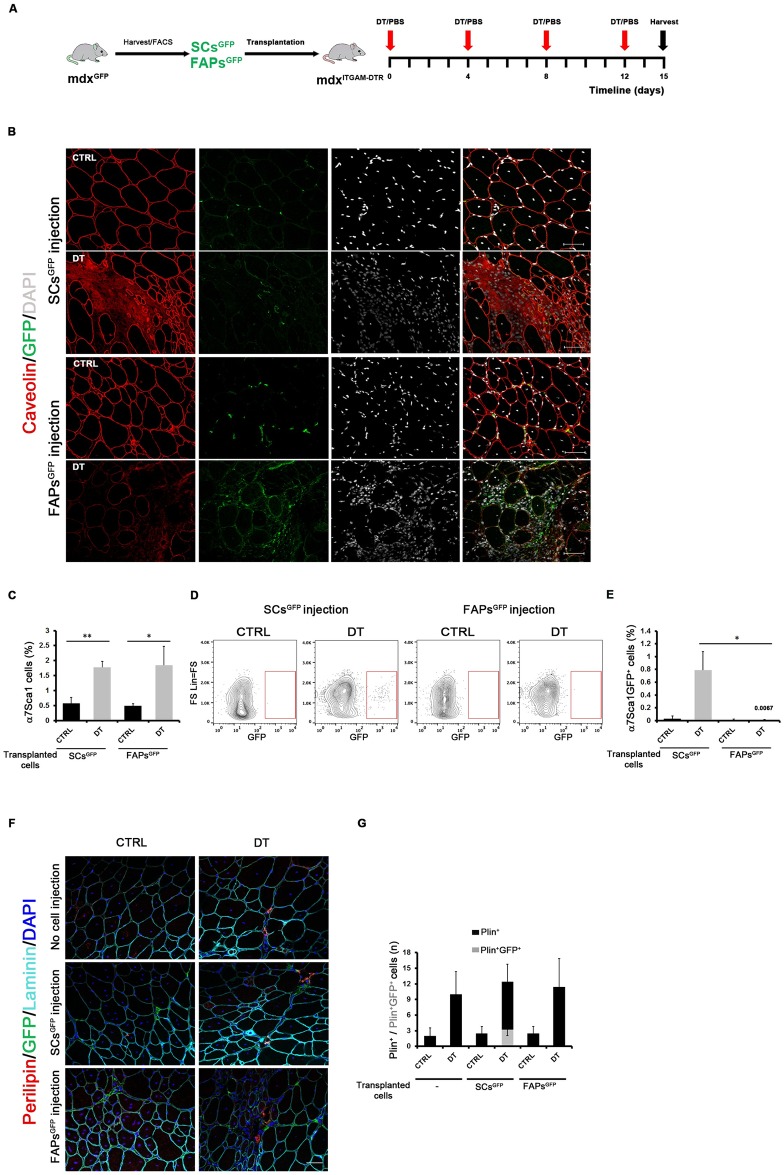
α7Sca1 cells derive from SCs upon MΦ depletion in dystrophic muscles.(A) Schematic representation of transplantation experiment. A detailed description is reported in the Results section. (B) Representative images of double staining anti-caveolin (red) and anti-GFP (green) of TA cryosections of mdxITGAM-DTR mice transplanted with SCsGFP and FAPsGFP and injected with PBS (CTRL) or DT. Nuclei were counterstained with DAPI (white); n = 3 animals for each experimental group. Scale bar = 50 μm. (C) Percentage of α7Sca1 cells purified from Lin- cell population of PBS or DT-injected mdxITGAM-DTR mice transplanted with SCsGFP and FAPsGFP; the percentage of α7Sca1 cells is reported as relative to whole mononucleated cells; n = 3 animals for each experimental group; each replicate was the pool of 2 mice; unpaired t test was used for comparison (*, P<0.05; **, P<0.01). (D) Representative FACS plot showing α7Sca1 GFP+ cells sorted from PBS (CTRL) or DT-injected mdxITGAM-DTR mice transplanted with SCsGFP or FAPsGFP. (E) Graph reporting the percentage of α7Sca1 GFP+ cells sorted from PBS or DT-injected mdxITGAM-DTR mice transplanted with SCsGFP or FAPsGFP; the percentage of α7Sca1 GFP+ cells is reported as relative to whole mononucleated cells; n = 3 animals for each experimental group; each replicate was the pool of 2 mice; unpaired t test was used for comparison (*, P<0.05). (F, G) Representative images of triple staining anti-perilipin (Plin) (red), anti-GFP (green), anti-caveolin (cyan) of TA cryosections of mdxITGAM-DTR mice not subjected to cell injection or transplanted with SCsGFP and FAPsGFP and injected with PBS (CTRL) or DT. Nuclei were counterstained with DAPI (white); n = 3 animals for each experimental group. Scale bar = 50 μm. (G) Graph reporting the quantification of total Plin+ cells and double Plin+/GFP+ cells, represented as stacked columns and reported as mean number per field (n) ±SEM (n = 3–5 biological replicates for each experimental group).